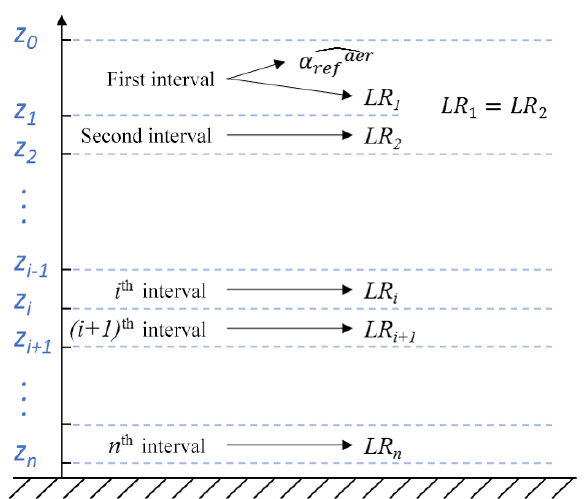
Figure 4. Diagram of the i th ( i = 1, 2, ..., n ) altitude interval for the altitude range [ z i ,z i − 1 ] using the TDAM (top-down aerosol op- tical thickness matching)